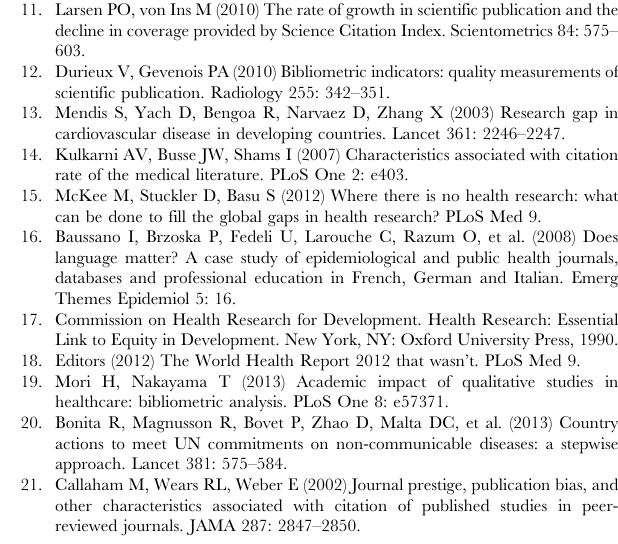
Figure S1 Country-level cardiovascular research publi- cations against total scientific and technical publications in 1999 (A) and 2009 (B). Total scientific and technical publications as reported by the World Bank with color coding representing World Bank country income status. The size of each country’s bubble represents the population size of that